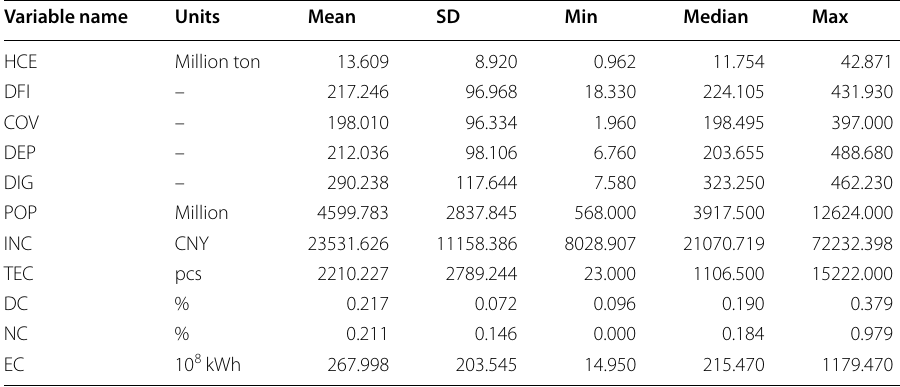
Table 1 Descriptive statistics of